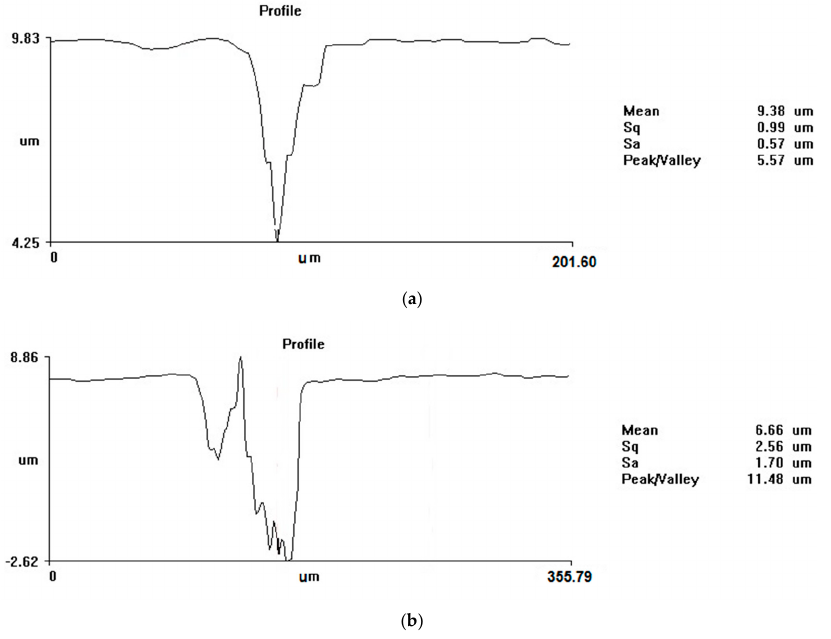
Figure 2. Profile of holes drilled in steel in water, using 10 kHz and ( a ) 500 pulses; ( b ) 100,000 pulses.